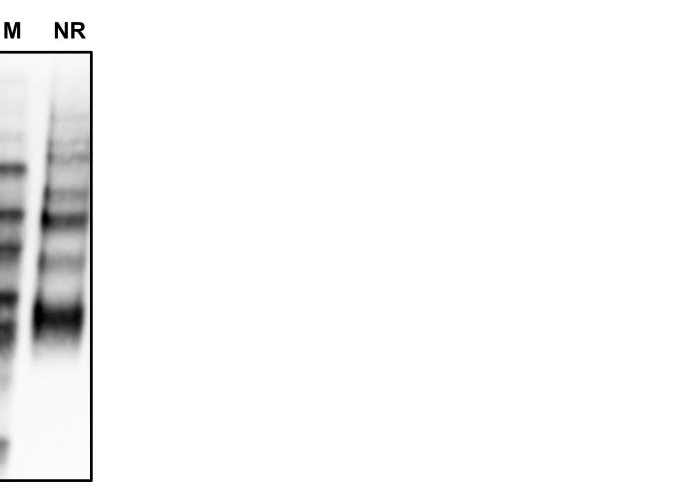
Figure 9. Analysis of purified mbE1E2 by reducing (R) and nonreducing (NR) Western blots. Both blots were probed with the anti-E2 antibody HCV1.